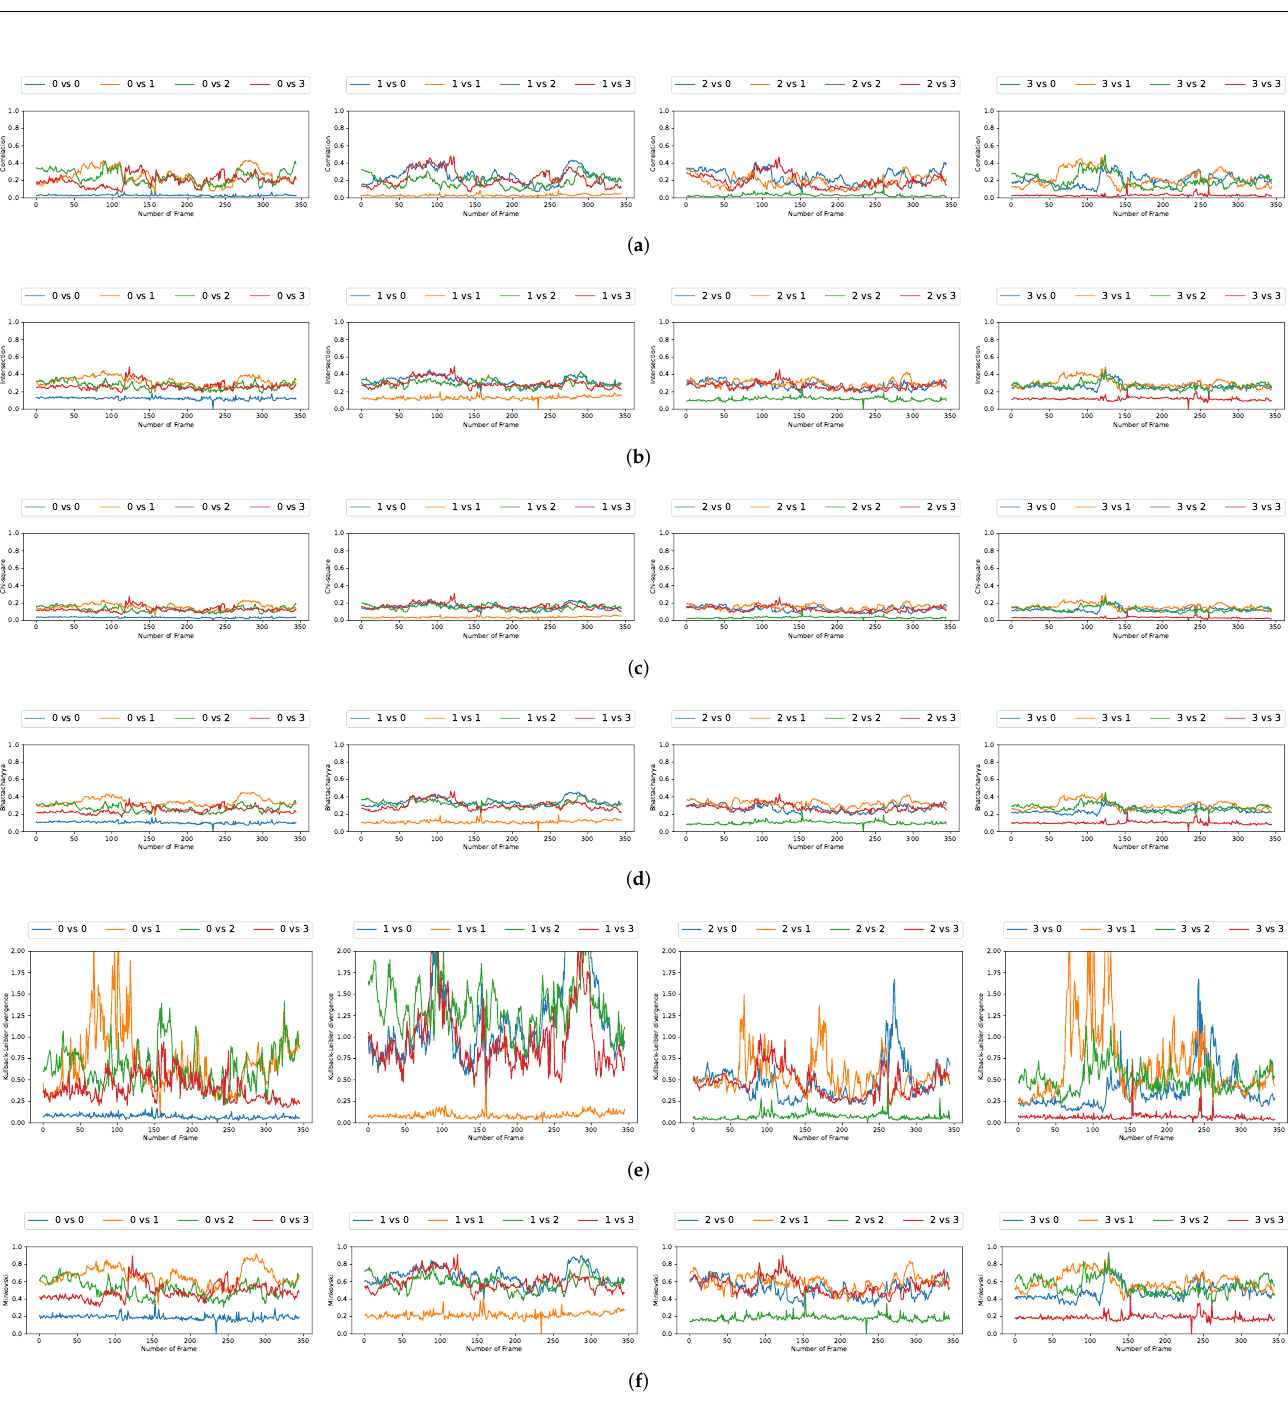
Figure 5. Curves comparing persons from one frame to another in video 1 (persons 0, 1, 2, and 3). ( a ) RGB and Correlation. ( b ) HLS and Intersection. ( c ) HSV and Chi-square. ( d ) L*a*b and Bhat- tacharyya. ( e ) L*u*v and KL divergence. ( f ) YCrCb and